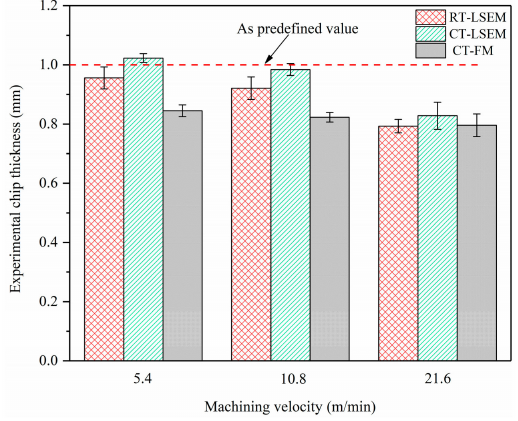
Figure 3. E ff ect of machining velocity on chip thickness of Al 7075 alloy subjected to RT-LSEM, CT-LSEM and